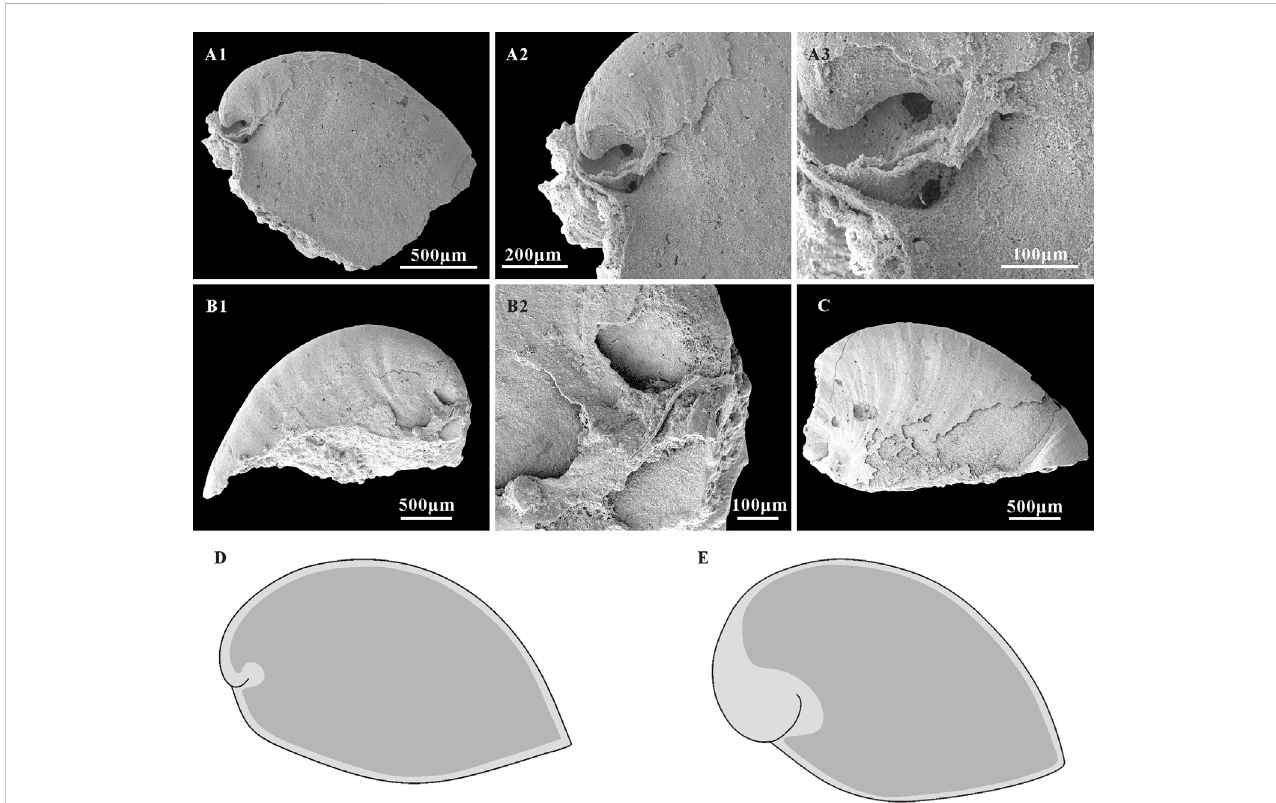
FIGURE 7 A.plana withexternalcoatingandassociatedschematicofshellsandinternalmoldextentin Anabarella . (A1,B1,C) Internalmolds,lateralview,CUBar128- 24, CUBar243-6, CUBar246-15,respectively. (A2,A3) magni fi cations of (A1) showingthemorphological variation ofexternal coating andinternalmold onthe apical areas of A. plana . (B2) Magni fi cation of (B1) , showing the shell morphology of A. plana on apical area. (D) Sketch of A. plana . (E) Sketch of A. australis , according the specimens showed in Li et al., 2019 (Figures 3I,H) . Dark gray, morphology of internal mold; light gray, morphology of shell. (A1) From the Member 5 of the Yanjiahe Formation in Yanjiahe Section, (B1,C) from the Member 5 of the Yanjiahe Formation in Gunziao